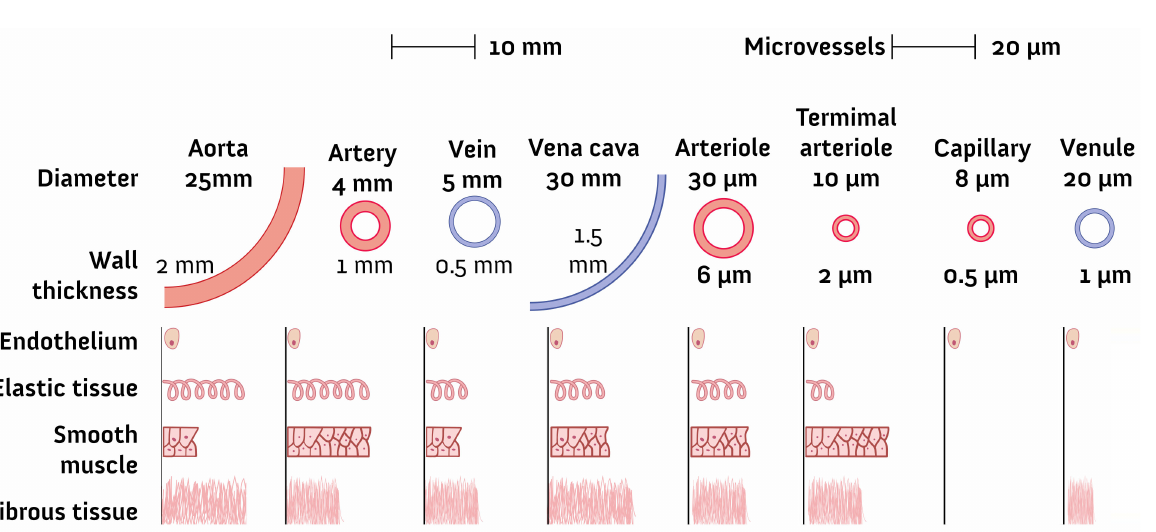
Figure 3. Blood vessel dimensions [73]; approaching real-size OOCs with dimensions less than 20 µ m is demanding and impossible without considering other properties as well as